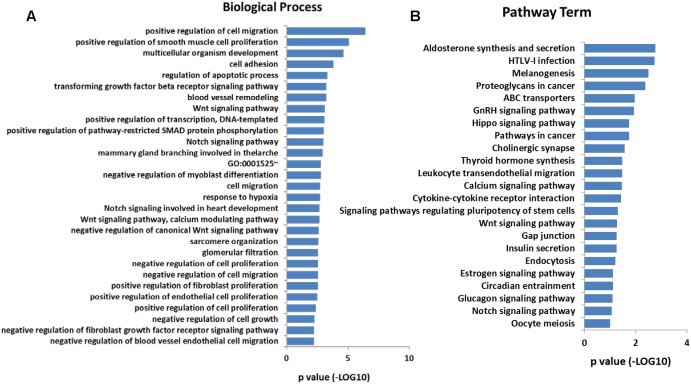
(A) Significantly enriched GO terms (top 30) of the overlap genes. (B) Significantly enriched signaling pathways of the overlap genes.